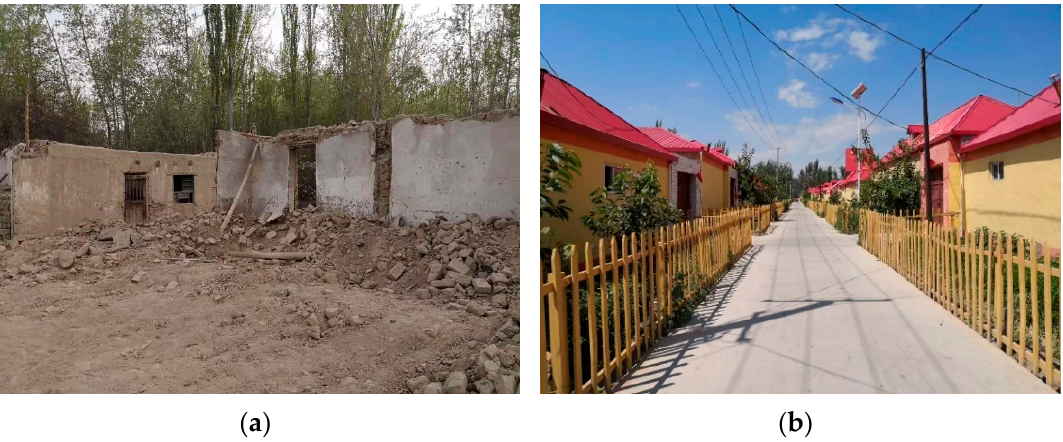
Figure 5. Comparison ( a ) before and ( b ) after village renovation.